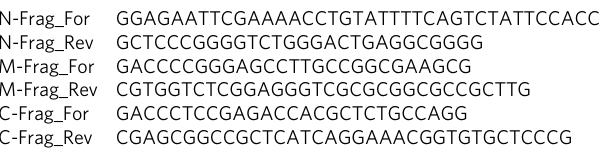
Table 2 Primer sequences for FXII genetic